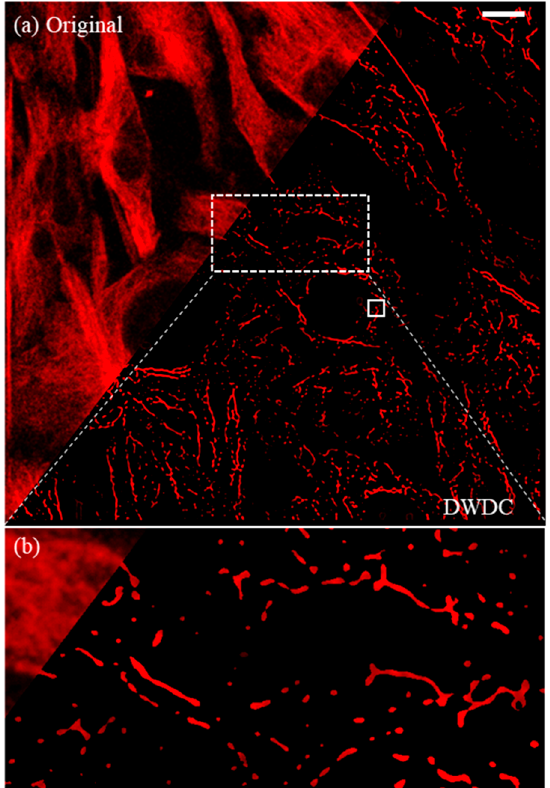
Figure 11. Comparison of original image and image processed after DWDC method. ( a ) Direct comparison before and after the DWDC method. The white scale bar represents 10 µm. ( b ) Local processing results of the DWDC method in the box of the dashed line of ( a ) for comparison with Figure 1b (see more details for 3D structure of Figure 11b in supplementary video S2).